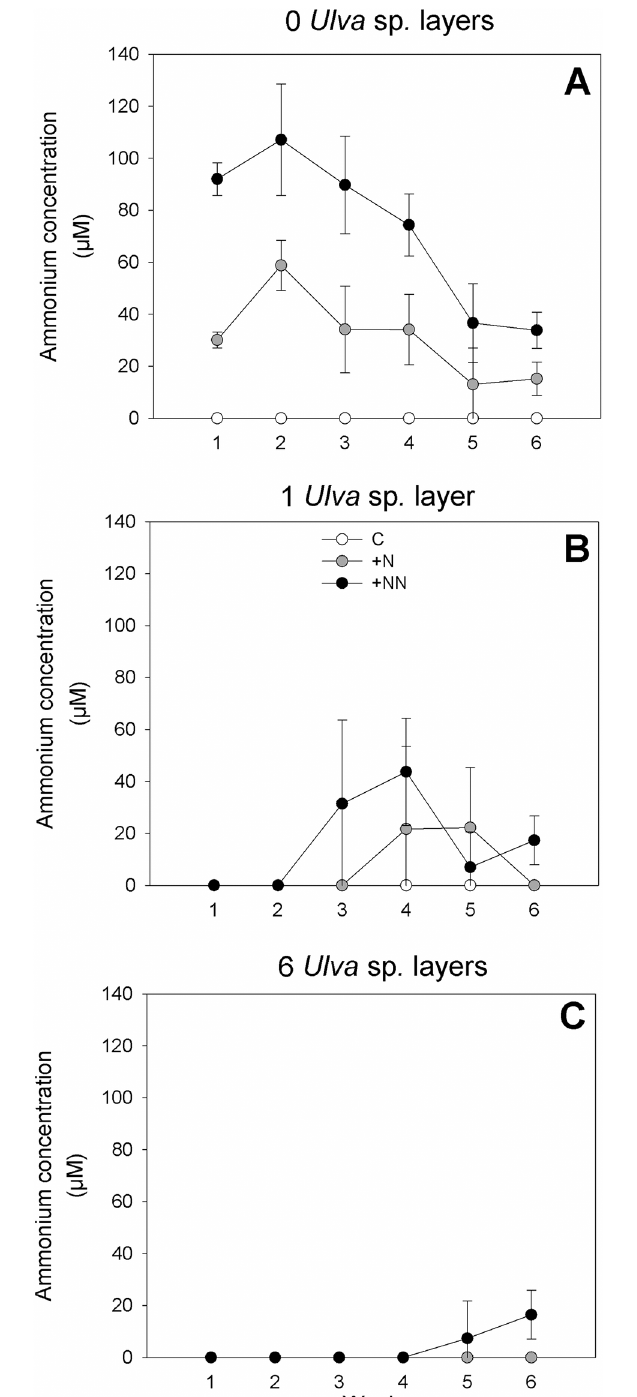
Fig 2. Change in ammonium concentrations at the end of the week over time ( μ M). A) No Ulva sp., B) 1 layer of Ulva sp., C) 6 layers of Ulva sp. Mean values ± 95% confidence limits (n = 3).